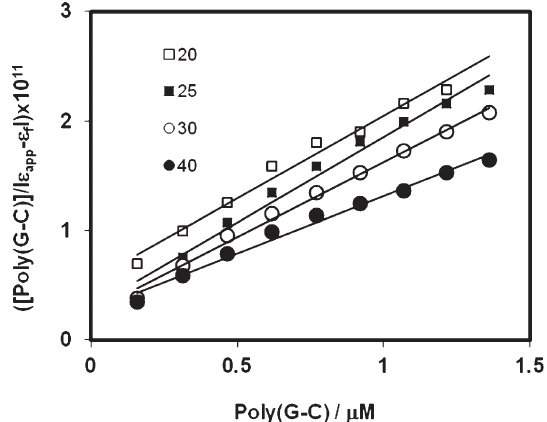
(cid:2) ( | ε app − ε f | ) versus